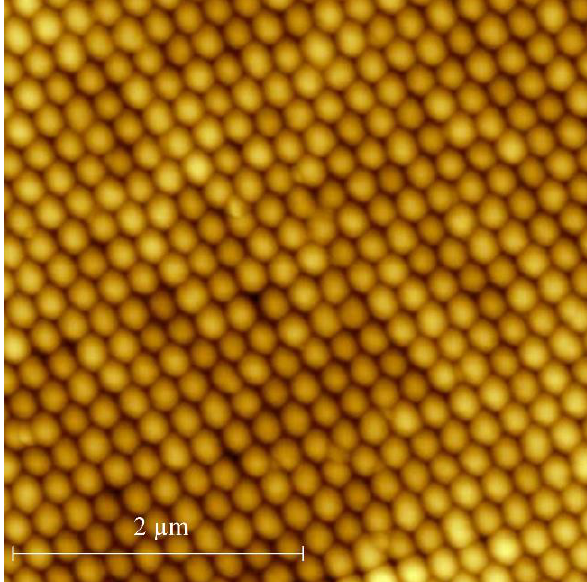
Figure 1. AFM image of the opal surface.